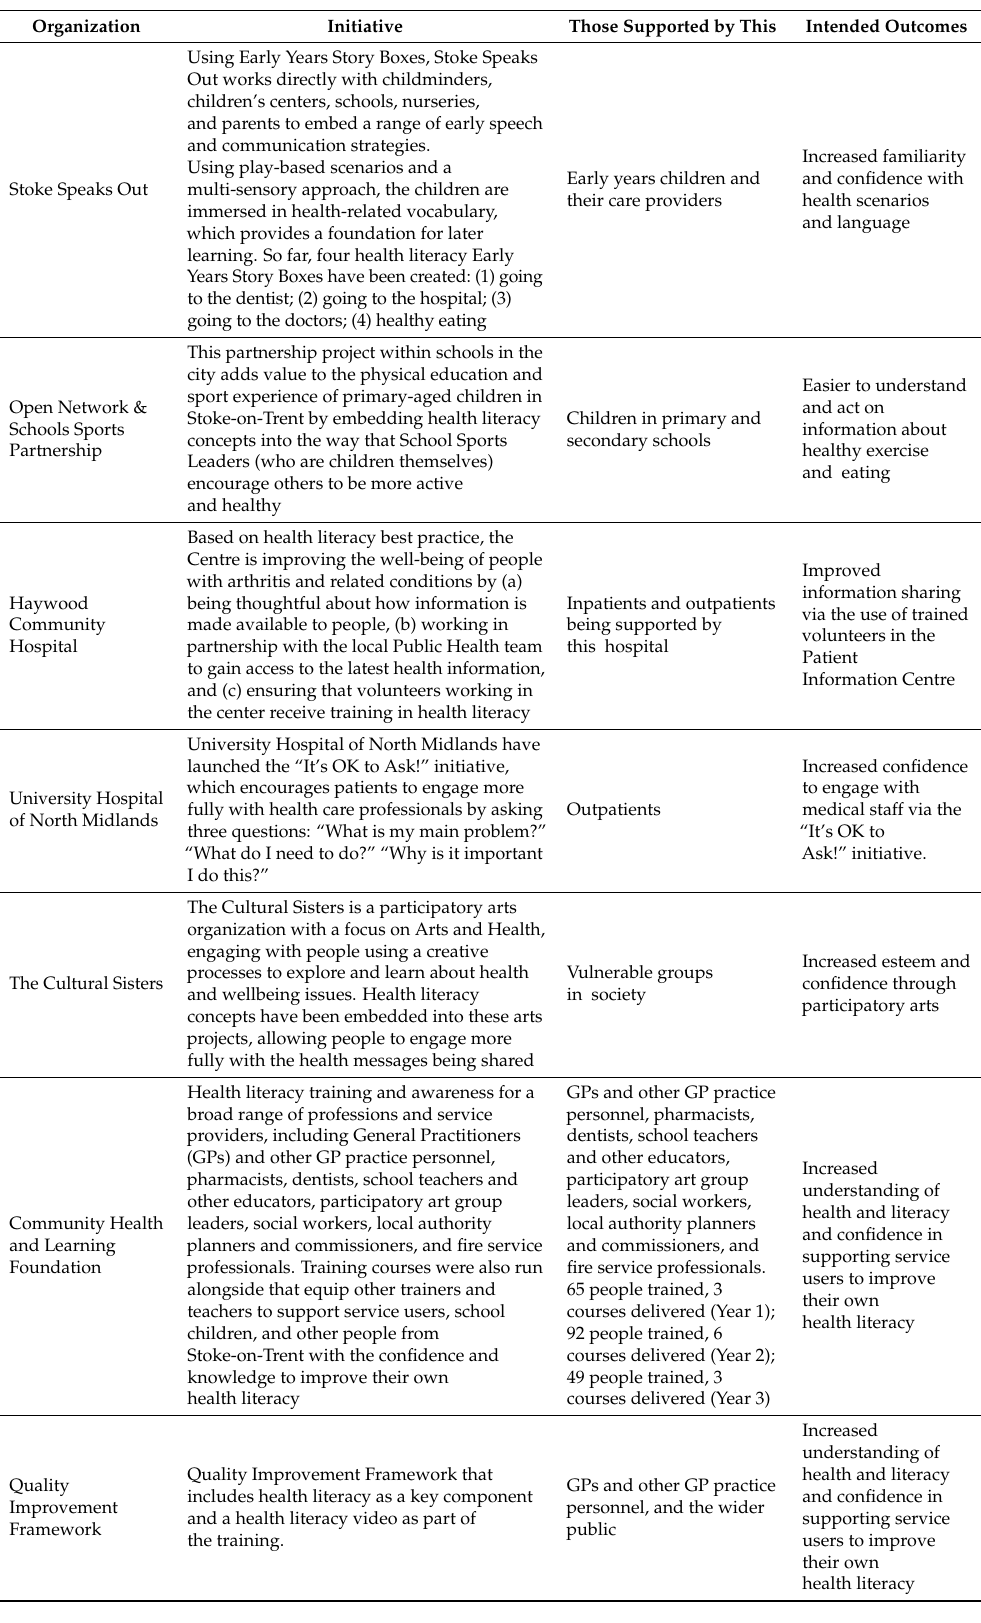
Table 2. Summary of key health literacy initiatives in Stoke-on-Trent (2015–2017).